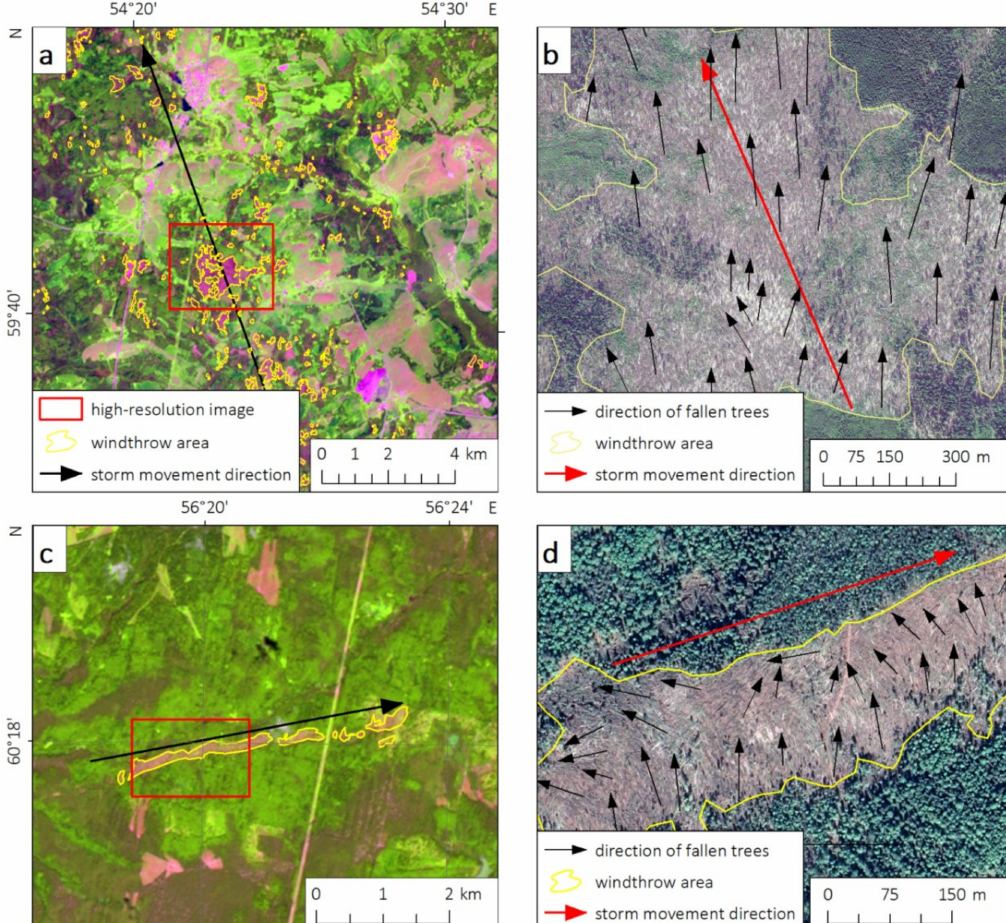
Figure 2. Identification of a windthrow areas in PR induced by a squall occurred on 18 July 2012 (line 1) and a tornado occurred on 13 September 2018 (line 2), based on satellite images: ( a , c ) the post-event satellite images from ( a ) Landsat (1 July 2013) and ( c ) Sentinel-2 (8 June 2019); ( b , d ) corresponding high-resolution images for the parts of windthrow areas highlighted with the red